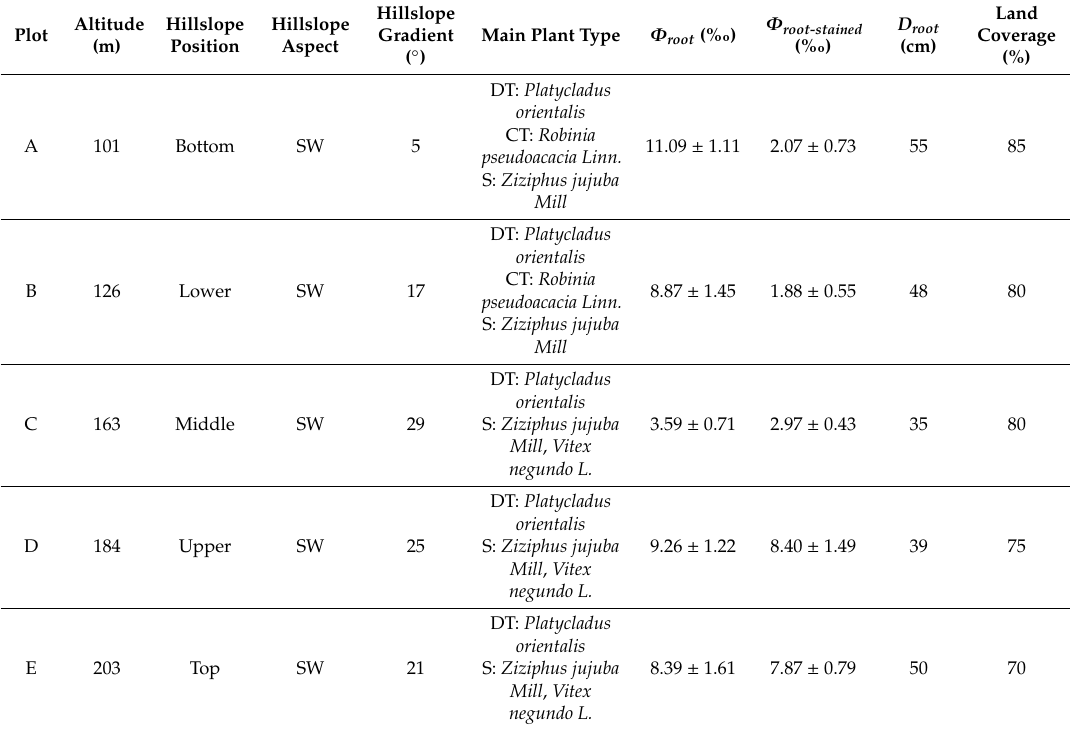
Table 1. Basic description of the experimental